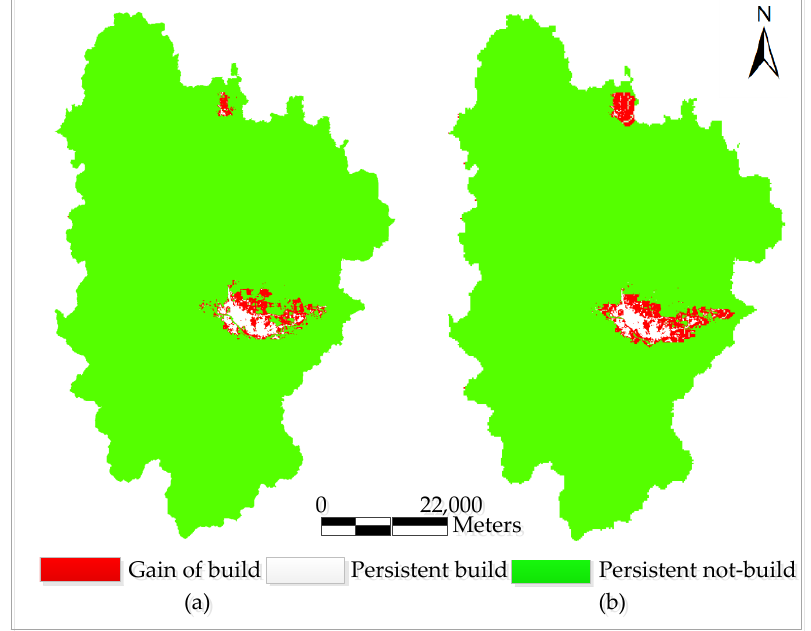
Figure 9. Actual construction land and simulated construction land map. The ( a ) is a real change in land use from 2008 to 2014. The ( b ) is a simulated change in land use from 2008 to 2014.